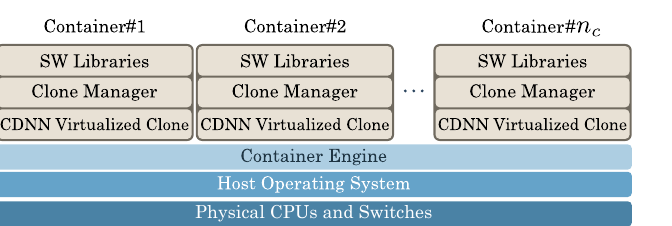
Figure 5. Logical view of a virtualized container-based Fog node. n c is the number of containers hosted by each Fog